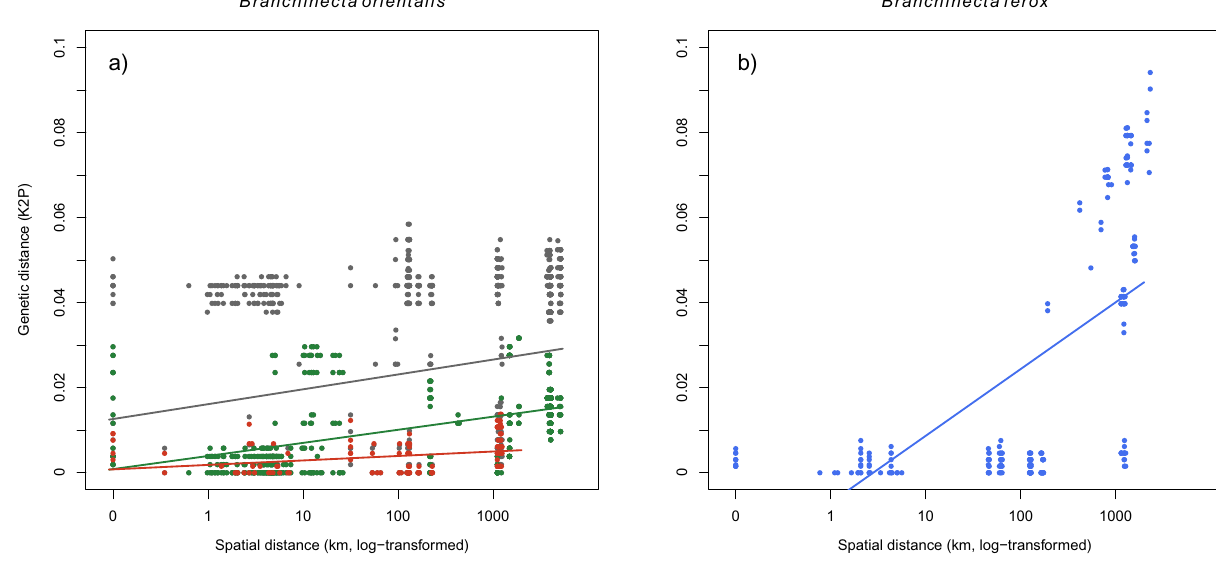
Figure 3. Genetic differentiation (genetic distances measured as Kimura 2-parameter; K2P) in relation to spatial distance, based on the mitochondrial COI gene fragment. ( a ) In B. orientalis , a significant distance decay relationship was found both for the full dataset (grey; Mantel test; nperm = 999, r = 0.22, p = 0.001) and in the separate analyses of the two clades (green: Clade A; r = 0.53, p = 0.001, red: Clade B; r = 0.26, p = 0.001; for the clades, see Fig. 2a,c). ( b ) In B. ferox , there was a significant distance decay in the full dataset (blue; r = 0.65, p = 0.001).